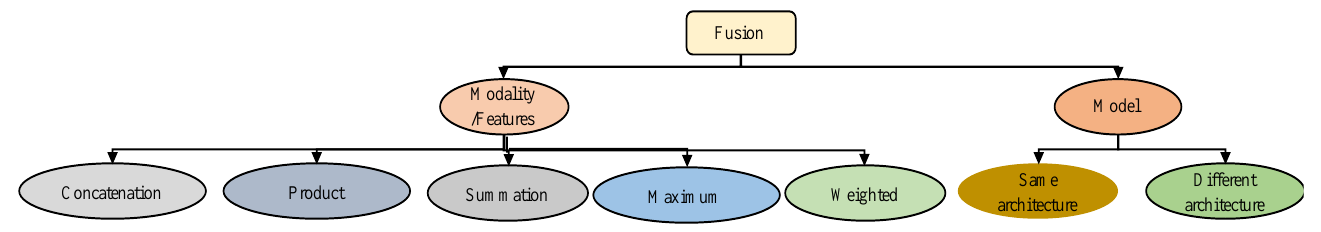
Figure 7. Different Fusion Types.